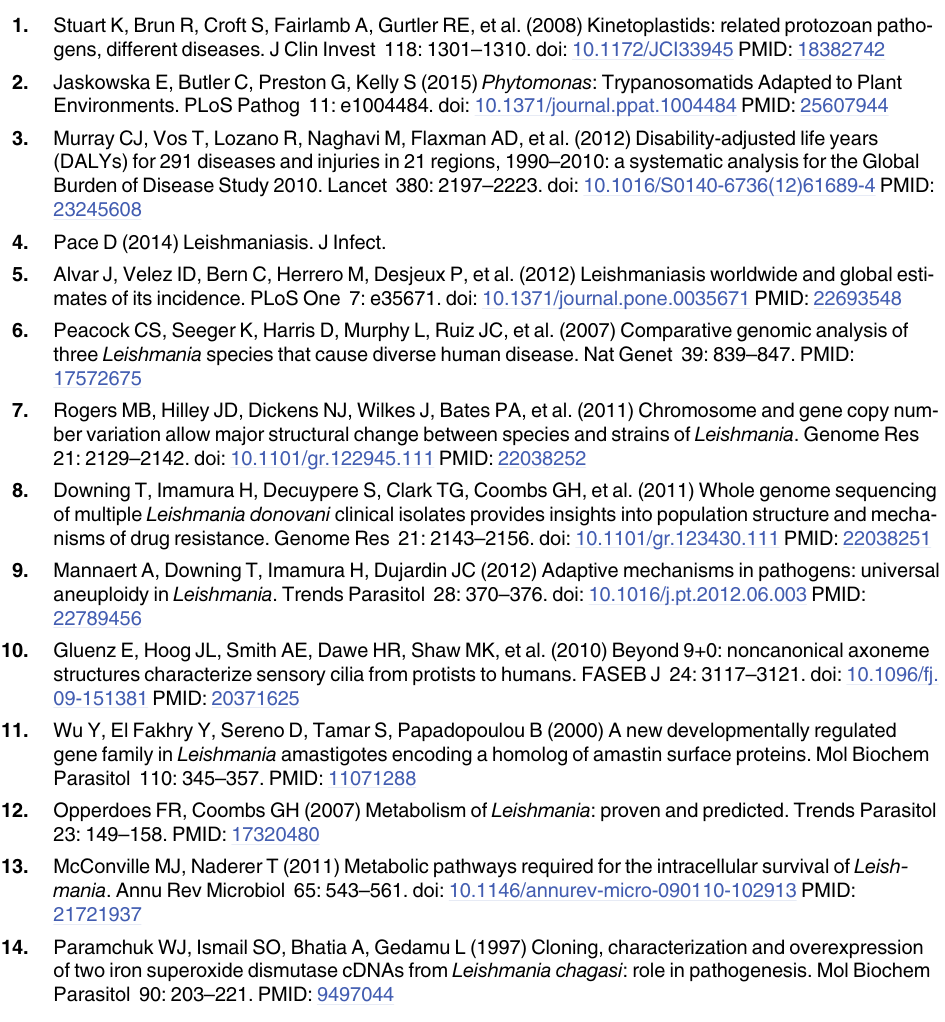
S22 Table. Distribution of differentially expressed genes across L . mexicana chromosomes.